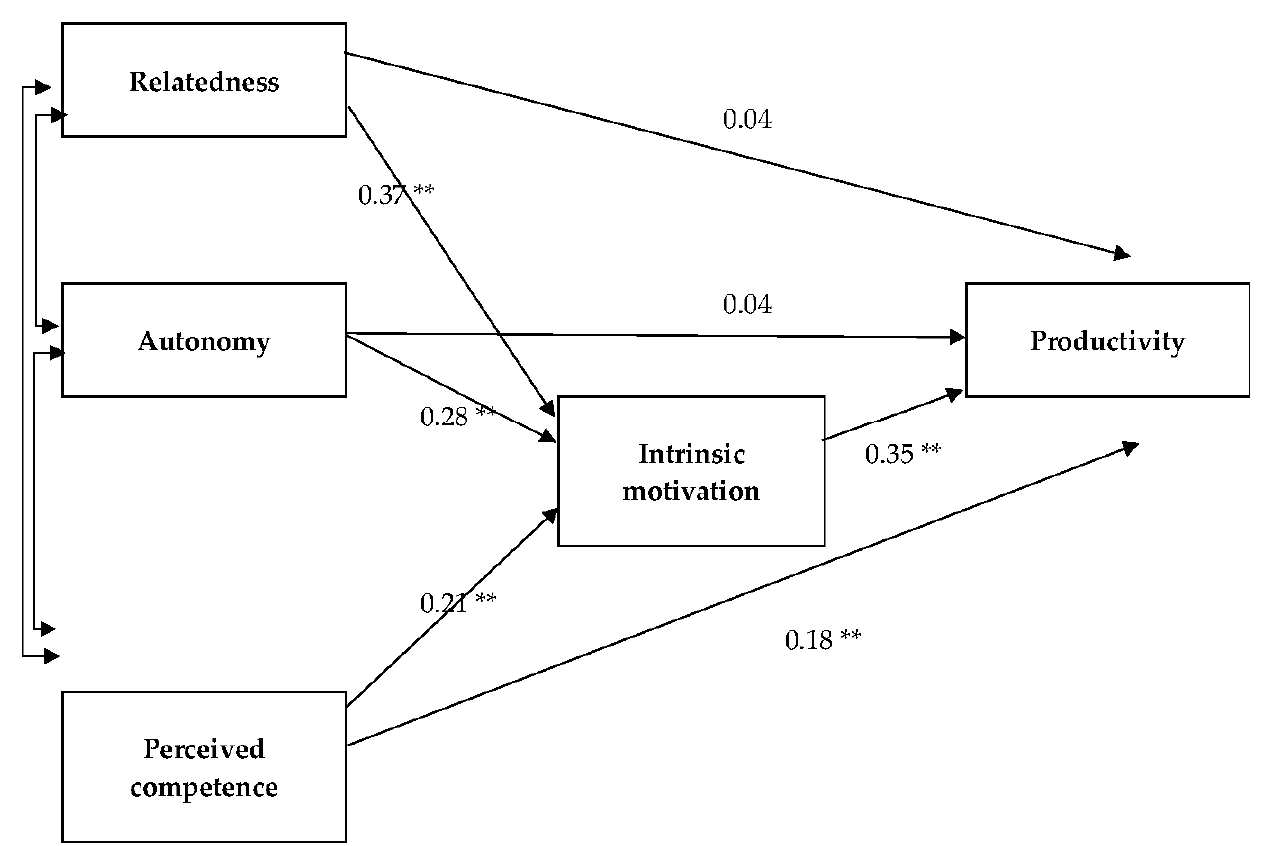
Figure 1. Standardised regression coefficients Model 1. ** p < 0.01.